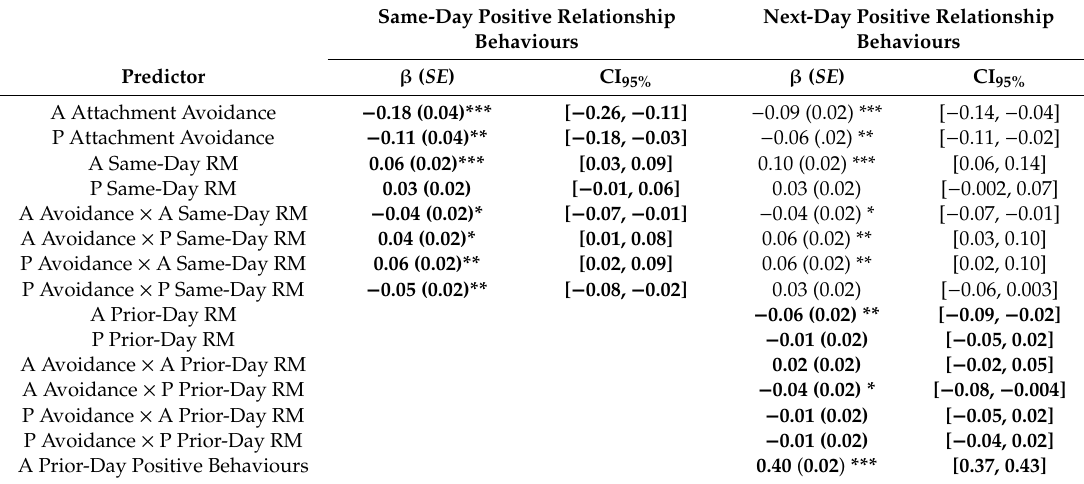
Table 5. Associations of attachment avoidance and daily relationship mindfulness with same-day and next-day positive relationship behaviours. Note. N = 100 couples. A = actor; P = partner; RM = relationship mindfulness. Higher scores on continuous variables represent greater standing on the variable (e.g., higher daily RM). For clarity, they key e ff ects in each model are in boldface. * p < 0.05, ** p < 0.01, *** p < 0.001.